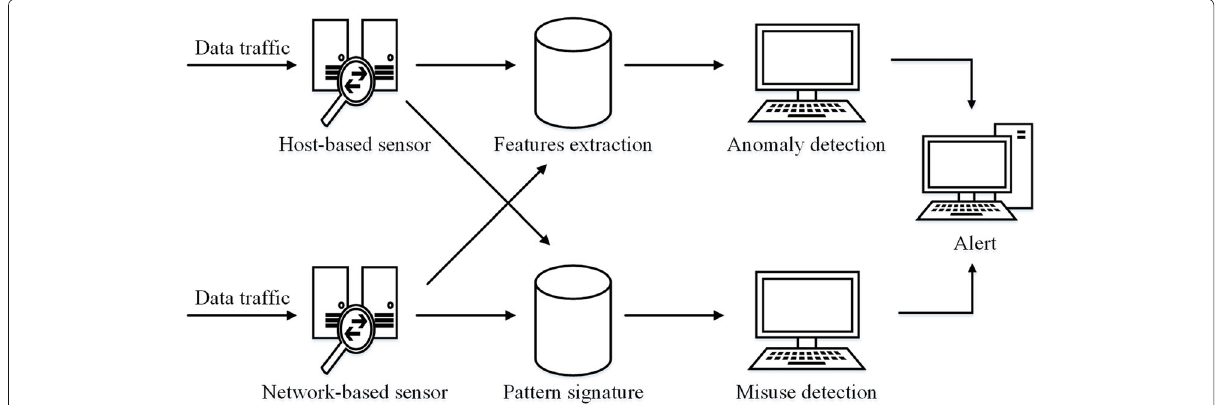
Fig. 5 IDS operations. IDS operations can be divided into the monitoring stage, the analysis stage and the detection